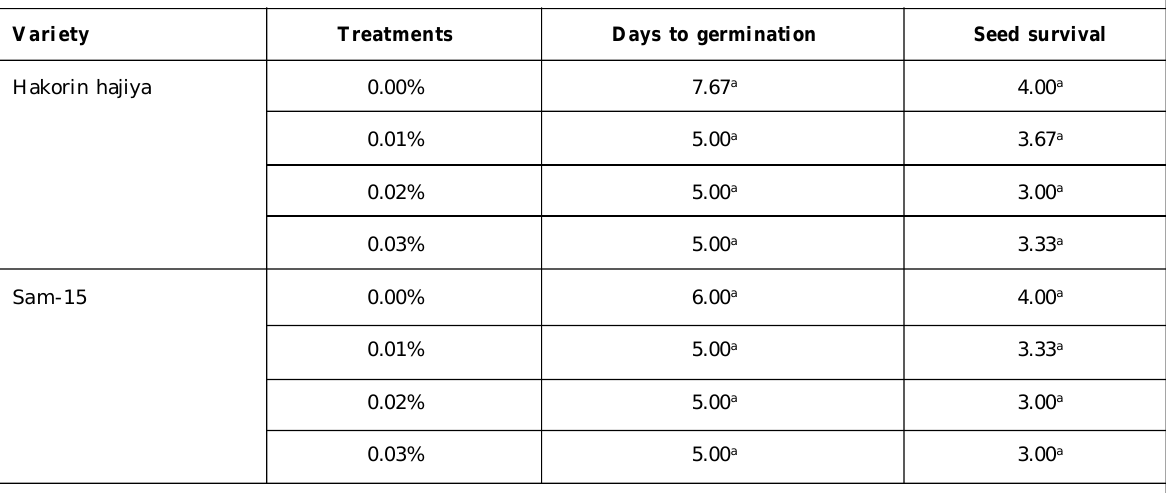
Table 1: Effects of sodium azide on seed germination Variety Treatments Days to germination Seed survival Hakorin hajiya 0.00%